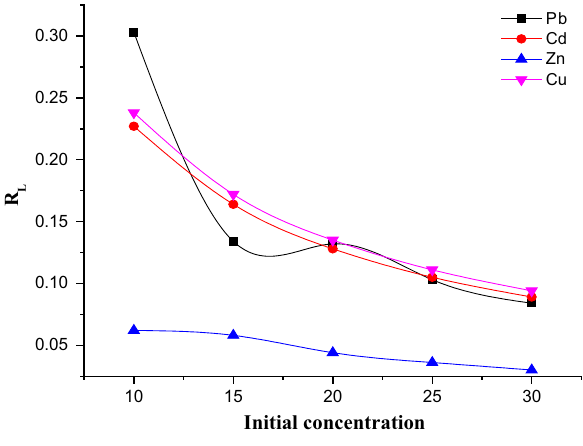
Fig. 12 Langmuir isotherm for Pb(II), Cd(II), Zn(II) and Cu(II) ion removal at various concentrations Fig. 13 Separation factors of Pb(II), Cd(II), Zn(II) and Cu(II) ion removal at various